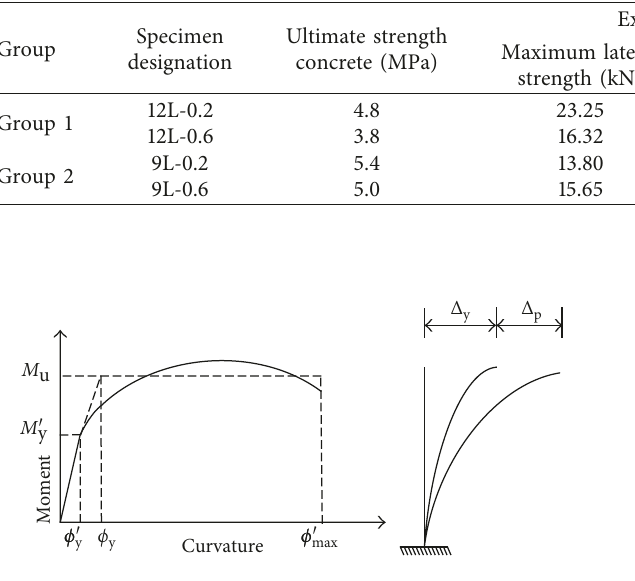
Figure 10: Lateral displacement-moment